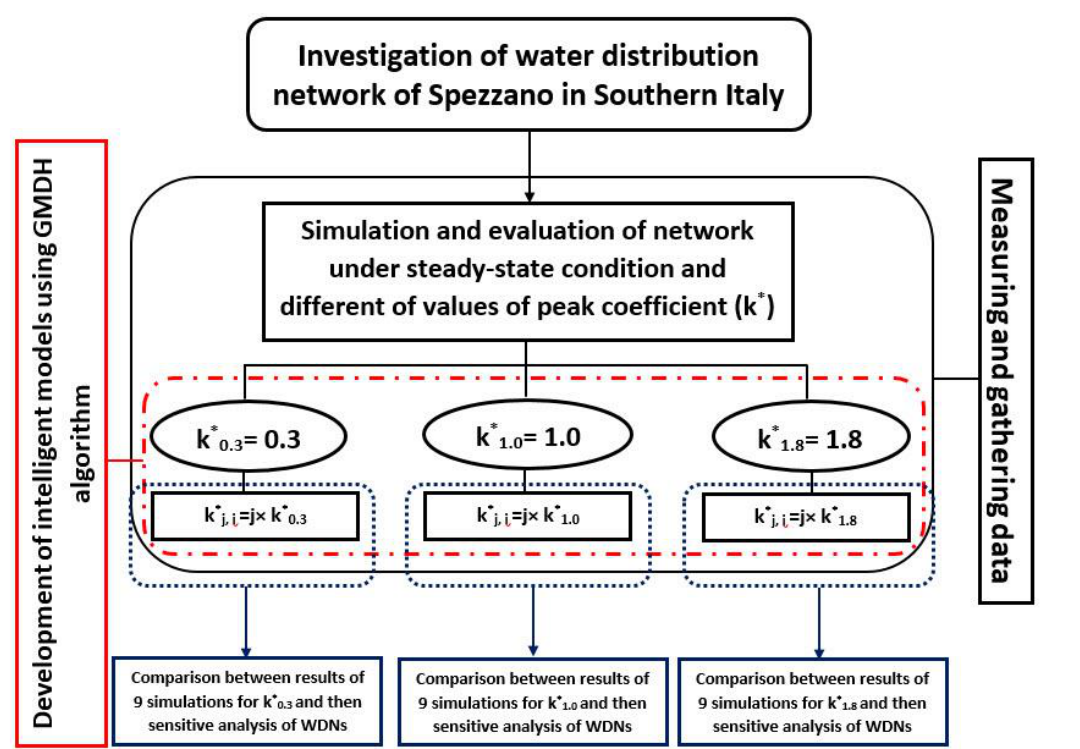
Figure 1. Flowchart of the study.